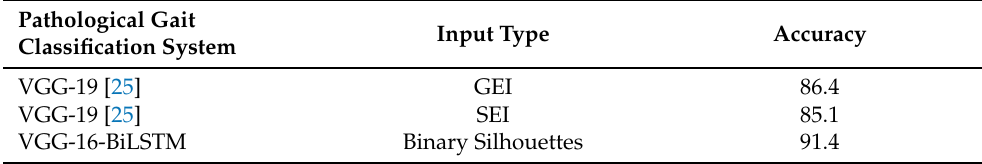
Table 3. Cross-database average accuracy results (%) of the proposed spatiotemporal deep learning gait classification framework: using GAIT-IT for training and GAIT-IST for testing; results are com- pared against a state-of-the-art solution using a VGG-19 CNN with the GEI or SEI gait representations. Pathological Gait Input Type Accuracy Classification System VGG-19